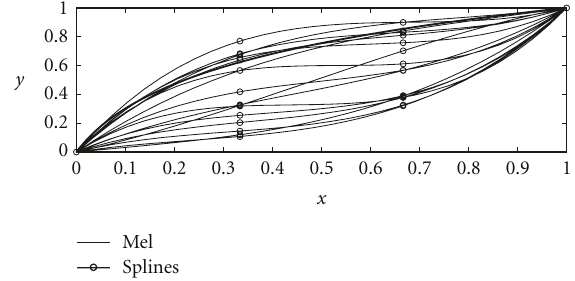
However, the second derivatives y (cid:3)(cid:3)